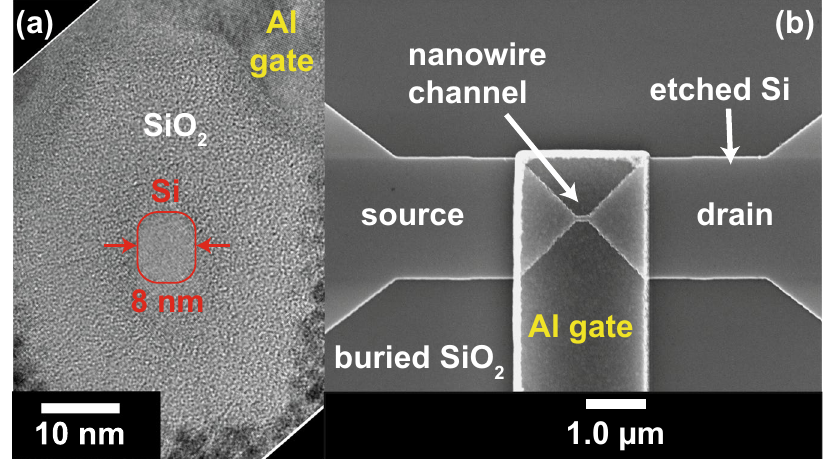
Figure 1. TEM and SEM images of the nanowire and transistor. ( a ) A cross sectional TEM image of the 8 ± 0.5 nm diameter nanowire with 16 nm SiO 2 thickness. ( b ) A SEM image of the gate over the top of the Si channel and parts of the source-drain regions. The nanowire length is 150